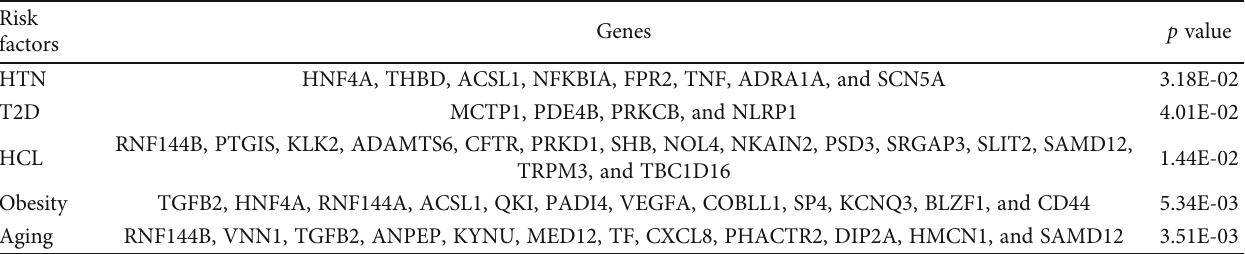
Table 6: Validation of the association of CVD with 5 risk factors employing gold benchmark